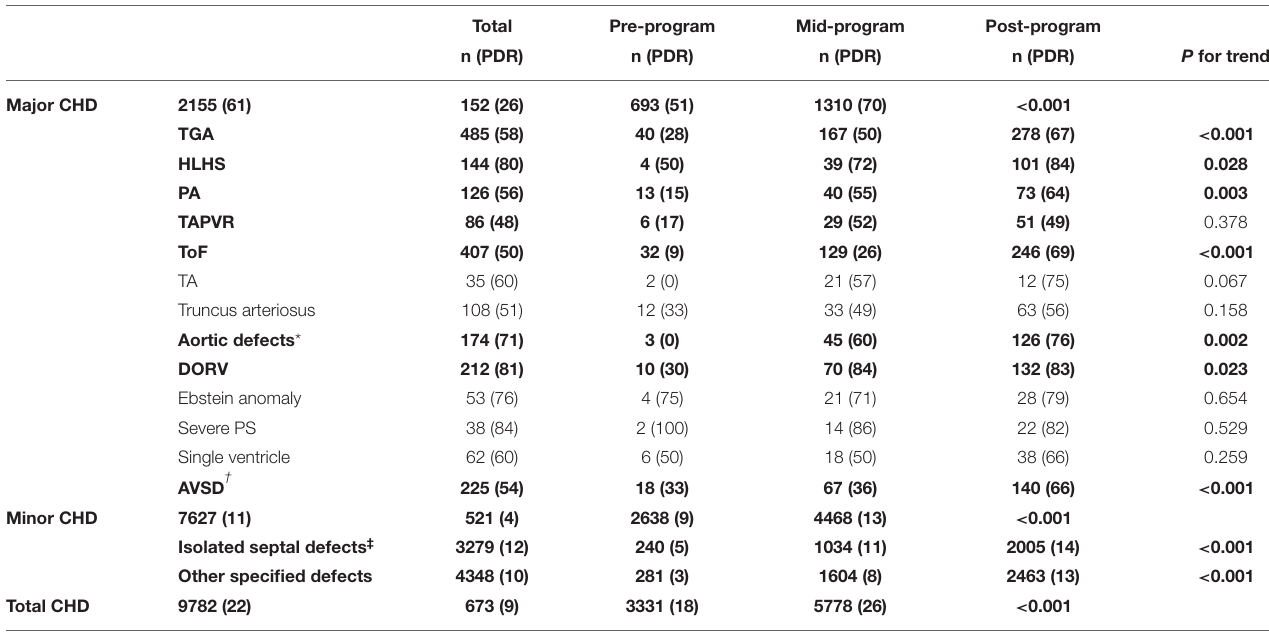
TABLE 2 | Prenatal congenital heart disease diagnoses, by subtype, 2004–2015. Total Pre-program Mid-program Post-program n (PDR) n (PDR) P for